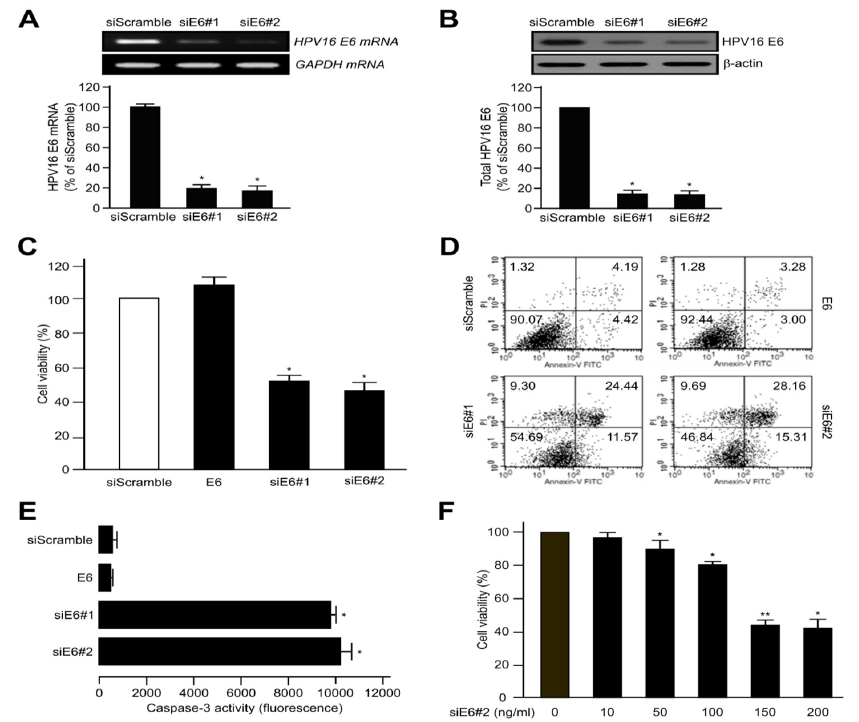
Figure 1. Human papillomavirus (HPV)16 E6 oncoprotein highly expressed by inactivating apoptosis in human cervical cancer cells. The control represents transfection of the siScramble. ( A , B ) Elimination of HPV16 E6 mRNA and protein expression by HPV16 E6-siRNA (siE6#1 or siE6#2) in CaSki cells. After transfection, the mRNA or protein expression of the cells was visualised via RT-PCR and western blots. The data are shown as the mean ± SD of at least three independent experiments. The mRNA and protein levels were evaluated via densitometric analysis and normalised to levels of the loading control; * p < 0.05 compared with siScramble group. ( C ) The relative rates of cell proliferation